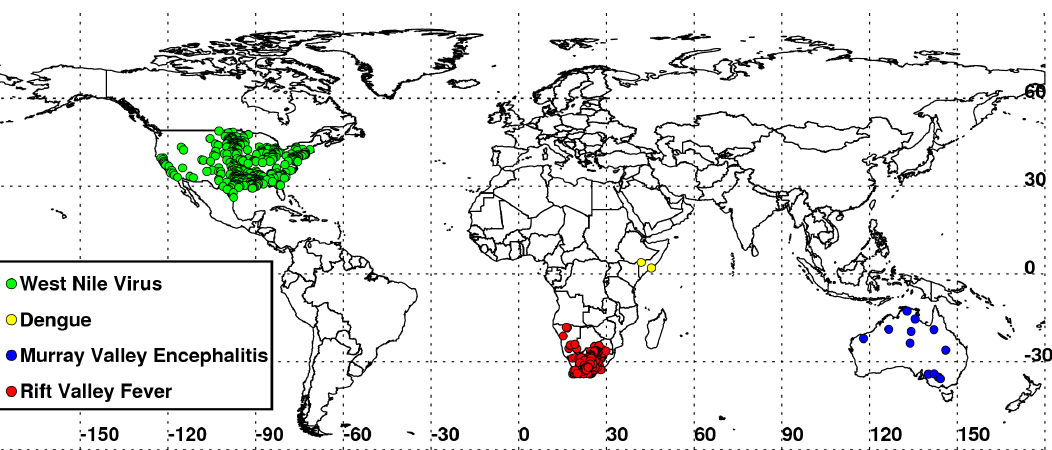
Figure 5. Global distribution of epidemics/epizootics of vector-borne disease outbreaks during 2010–2012 associated with weather extremes, showing the outbreak locations of West Nile virus disease (US, 2012), dengue (East Africa, 2011), Rift Valley fever (Southern Africa, 2011), and Murray Valley encephalitis (Australia, 2011).